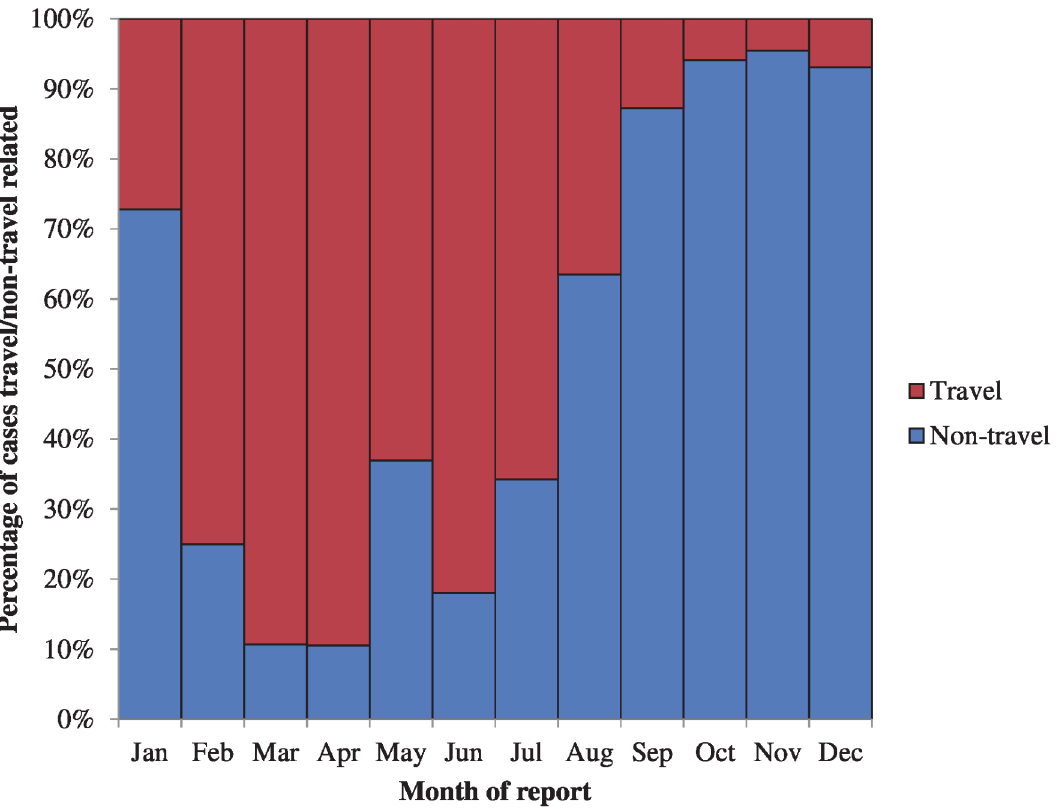
Fig 5. Percentage of confirmed dengue fever cases with/without travel history reported to the National Disease Surveillance System by month of report, Taiwan, 2010 – 2012.